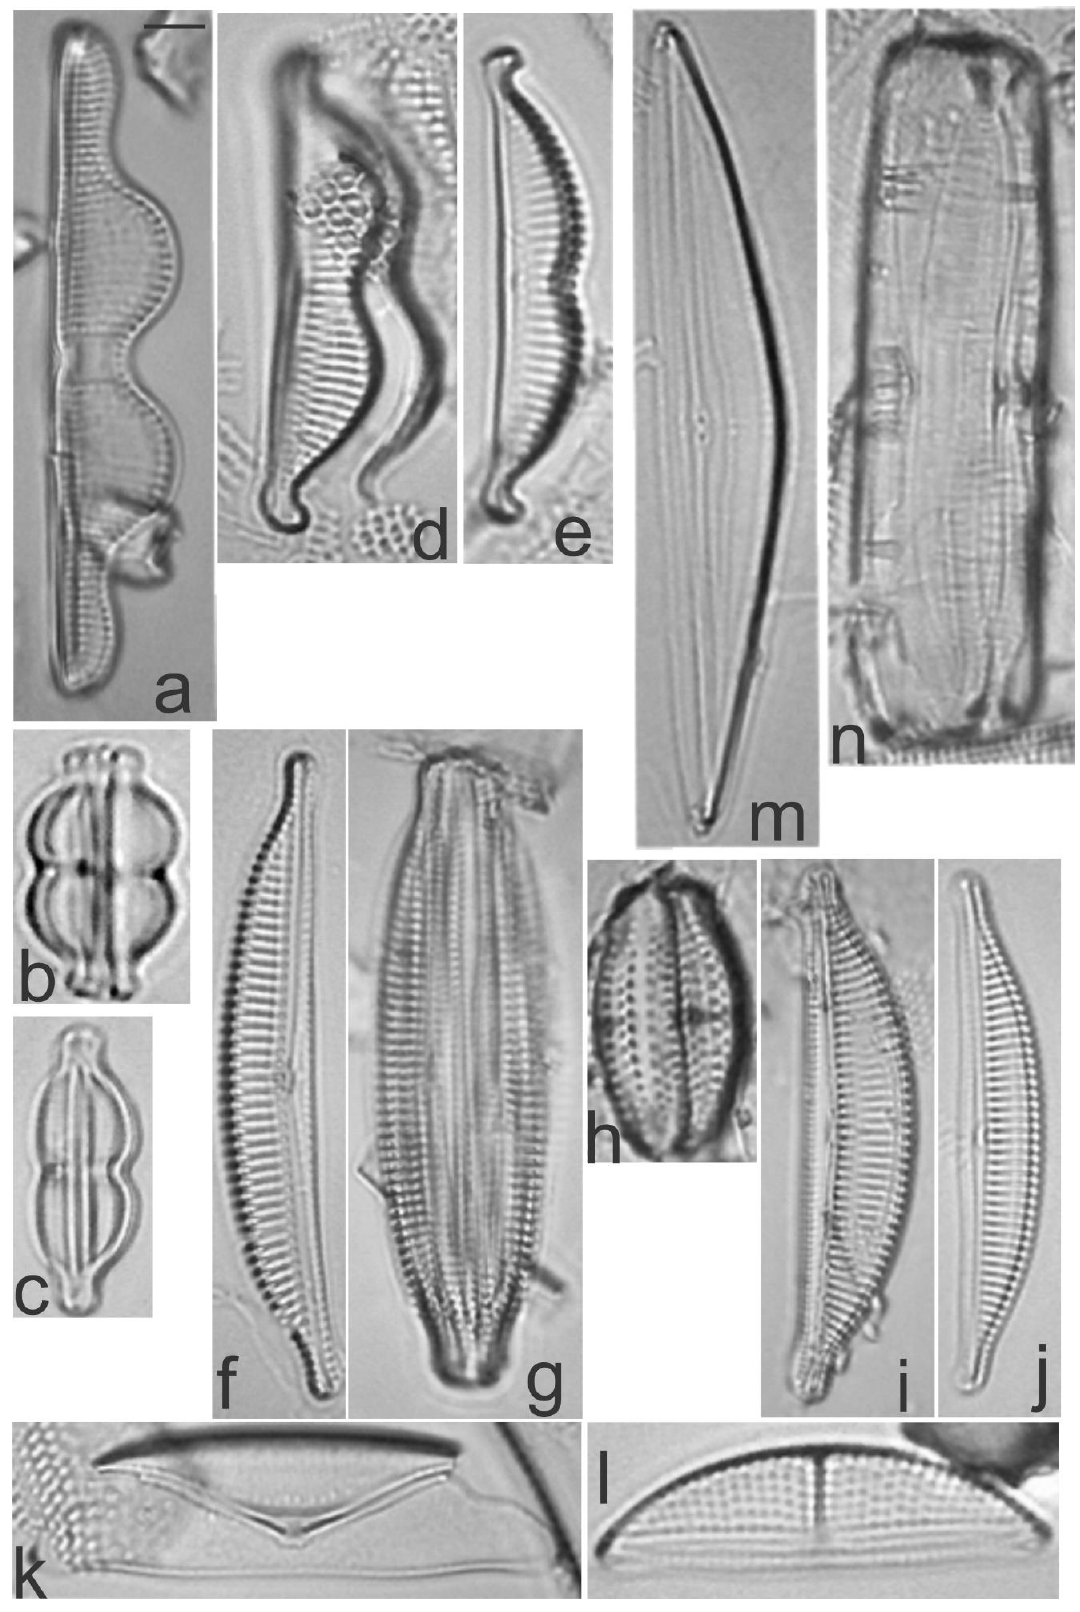
Figure 27. ( a ) Amphora bigibba var. interrupta ; ( b , c ) A. bigibba ; ( d ) A. biundulata ; ( e ) Halamphora subangularis ; ( f , g ) H. holsatica ; ( h ) A. maletractata var. constricta ; ( i ) H. acutiuscula ; ( j ) H. terroris ; ( k ) A. arenaria ; ( l ) Tetramphora ostrearia ; ( m ) Seminavis basilica ; ( n ) Amphora cf. obtusa var. rectangulata. Scale bar = 5 μm.